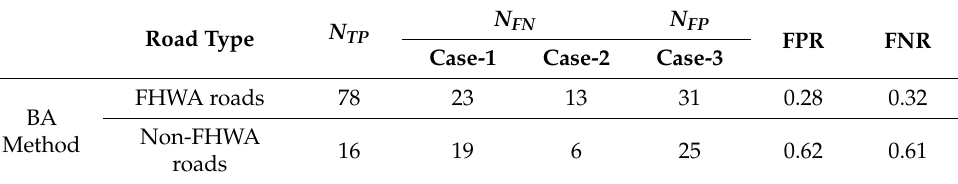
Table 1. True positives (TPs), false negative (FN), false positives (FPs), false positive rates (FPRs), and false negative rates (FNRs) of FHWA and non-FHWA roads originating from the culvert-modified DEM of the BA method.